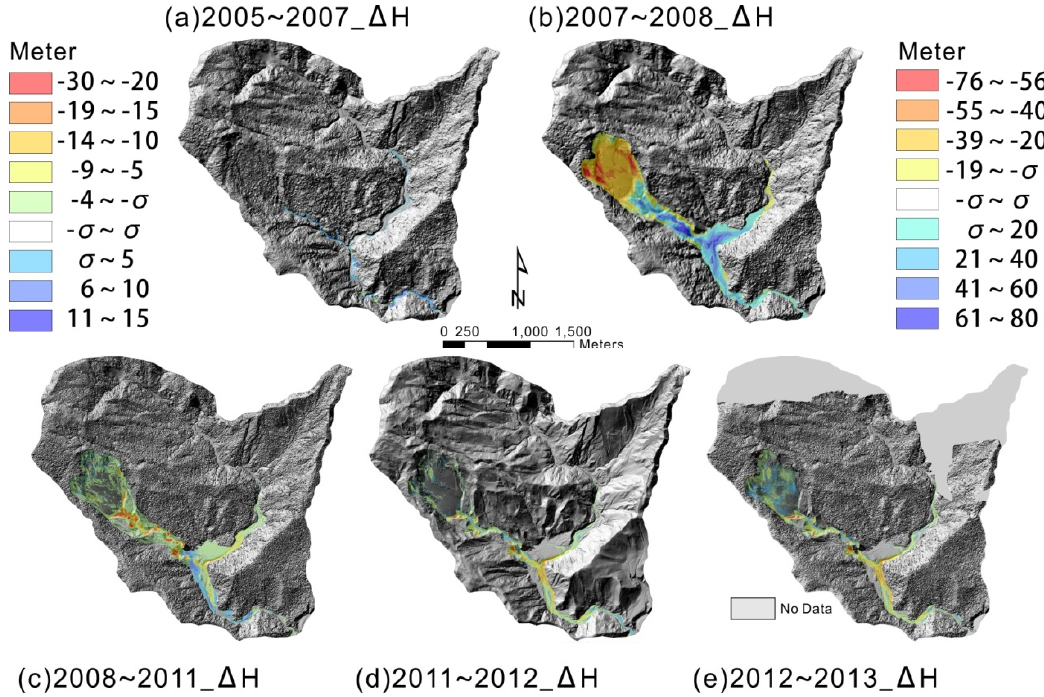
Figure 6. Images of terrain change over five periods calculated from multi-period digital terrain model (DTM) data in the Meiyuan Shan area. The color scale illustrates values of terrain change, where warm colors stand for an elevation decrease due to erosion, and cold colors represent an elevation increase led by the effects of deposition. ( a ) Terrain change (October 2005~October 2007) before the September 2008 landslide event; ( b ) Terrain change (October 2007~November 2008) right after the September 2008 landslide event. Please notice the markedly difference in elevation changes due to the fresh landslide event; ( c ) Terrain change (November 2008~August 2011); ( d ) Terrain change (August 2011~September 2012); ( e ) Terrain change (September 2012~June 2013). The scale for ( a , c – e ) is shown on the left; whereas, the one for ( b ) is shown on the right. σ is the total error of the two periods of DTM data shown in Table 4.